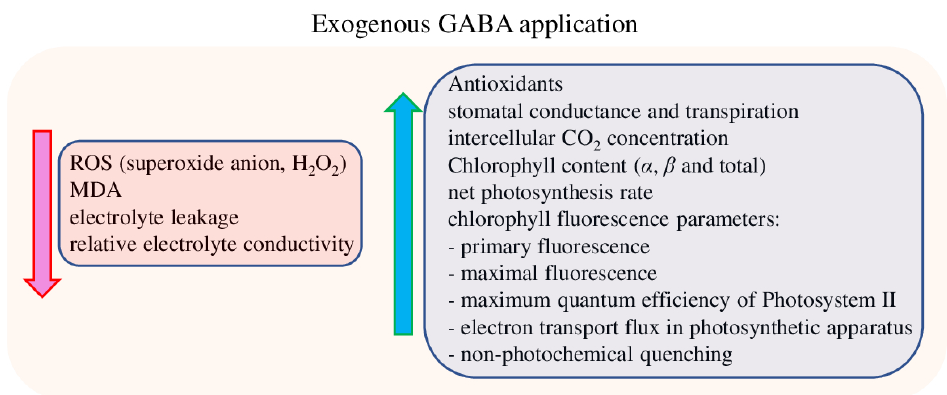
Figure 3. Chart summarizing the beneficial effects of GABA application on the photosynthetic ap- paratus, photosynthesis parameters, and antioxidant defense under salt